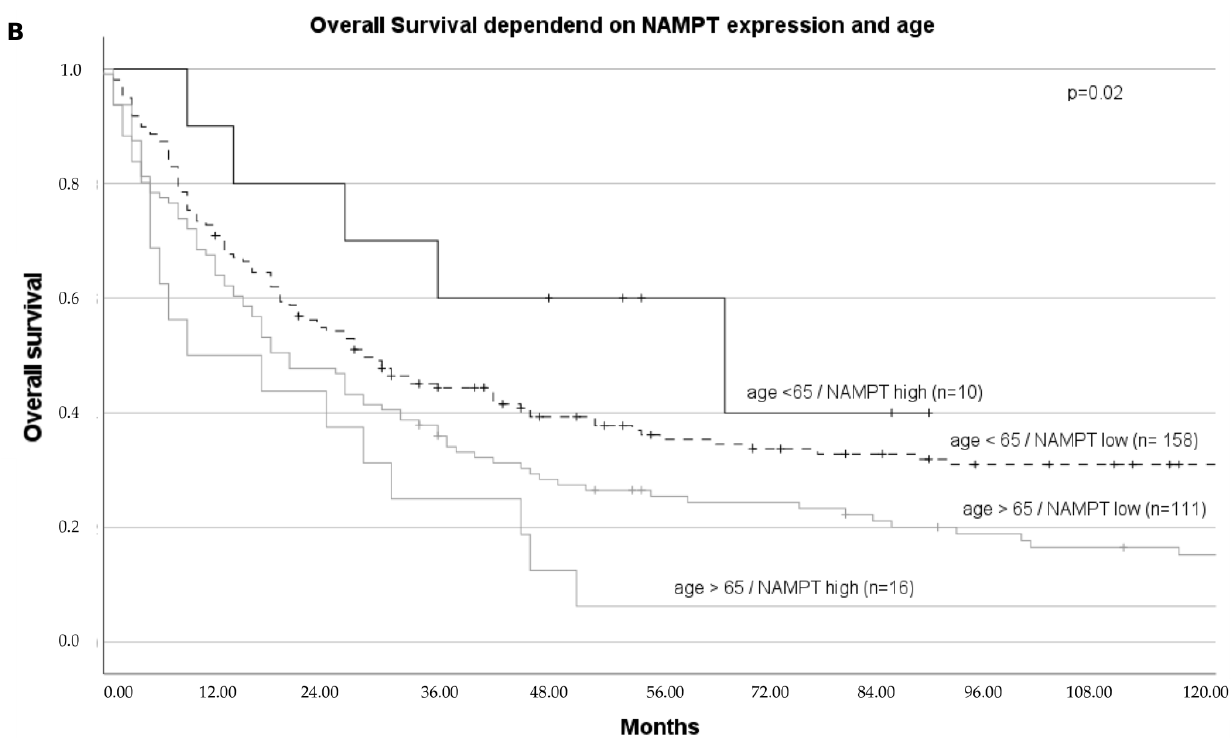
Figure 1. Kaplan–Meier plots of overall survival: ( A ) Overall survival depending on NAMPT Figure 1. Kaplan – Meier plots of overall survival: ( A ) Overall survival depending on NAMPT ex- expression (NAMPT high—solid line, NAMPT low—dotted line). ( B ) Overall survival depending on pression (NAMPT high — solid line, NAMPT low — dotted line). ( B ) Overall survival depending on NAMPT expression and age groups (age <65 years—black, age >65 years—gray, NAMPT high—solid line, NAMPT low—dotted